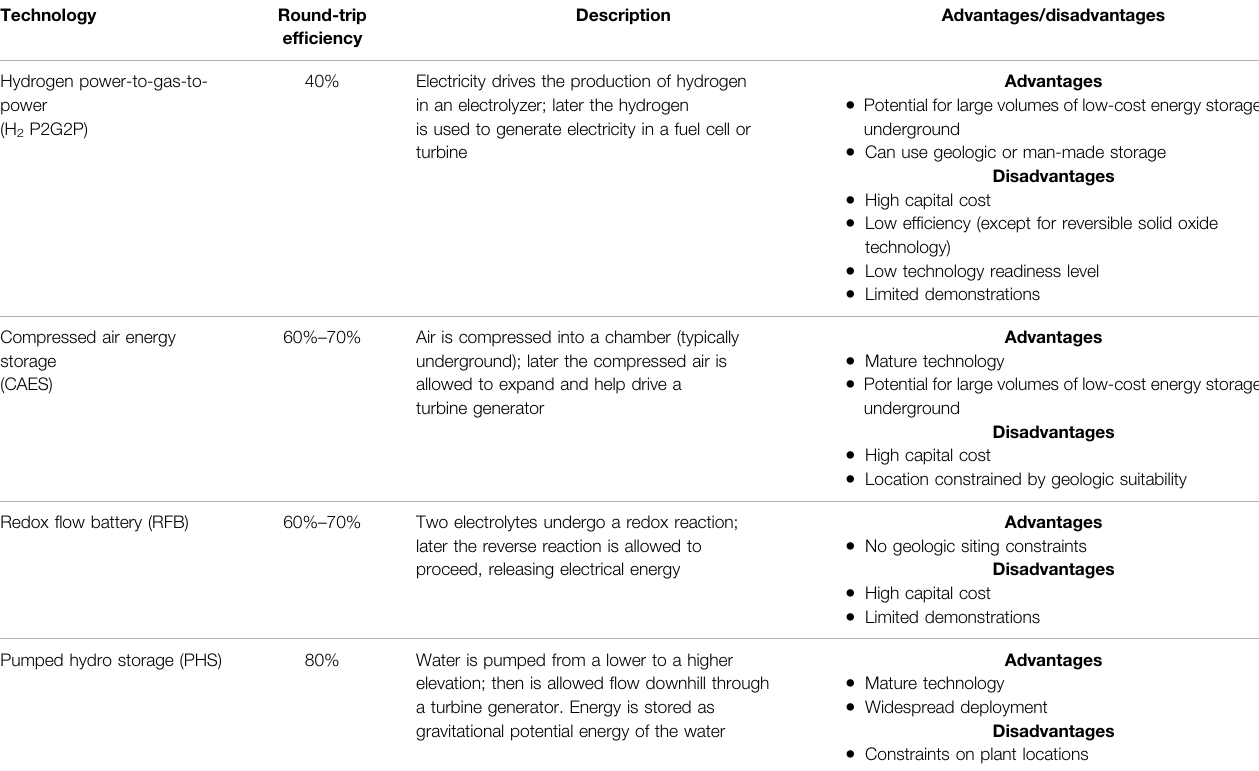
TABLE 2 | Summary of long duration energy storage technologies considered in this study. Technology Round-trip ef fi ciency